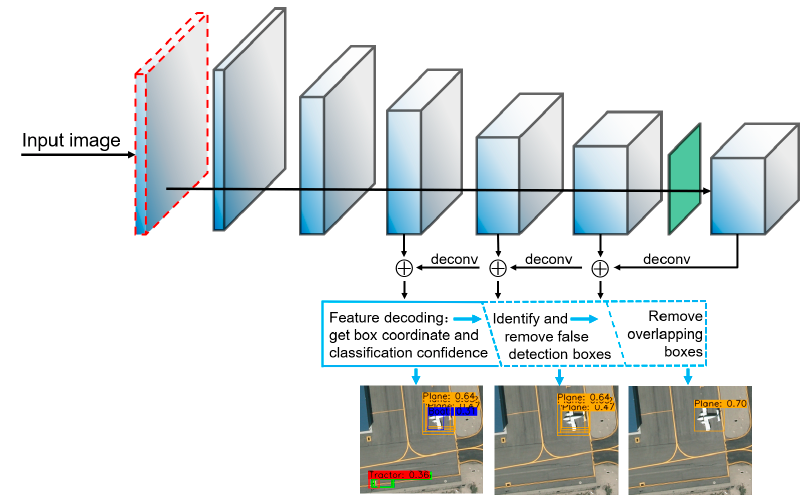
Figure 1. The detection network structure. The upper side is the CorrNet for extracting the features of the input images. The lower side is the post-processing part of the detection results. The blue dotted box is the dual-NMS.